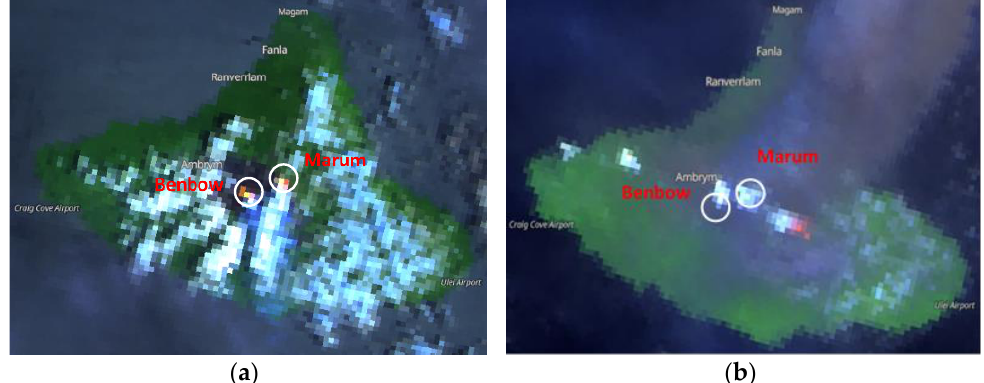
Figure 8. SLSTR (Sea and Land Surface Temperature Radiometer) RGB (Red = SWIR2; Green = SWIR1; Blue = NIR) maps of: ( a ) 14 December 2018 at 22:04 UTC; ( b ) 15 December 2018 22:17 UTC. Red/yellow pixels indicate the thermal anomaly associated with the lava lakes at the Benbow and Marum craters (left panel), and the lava flow from the 15 December fissure eruption (right panel). Maps were generated using the Sentinel Hub EO Brower [22].